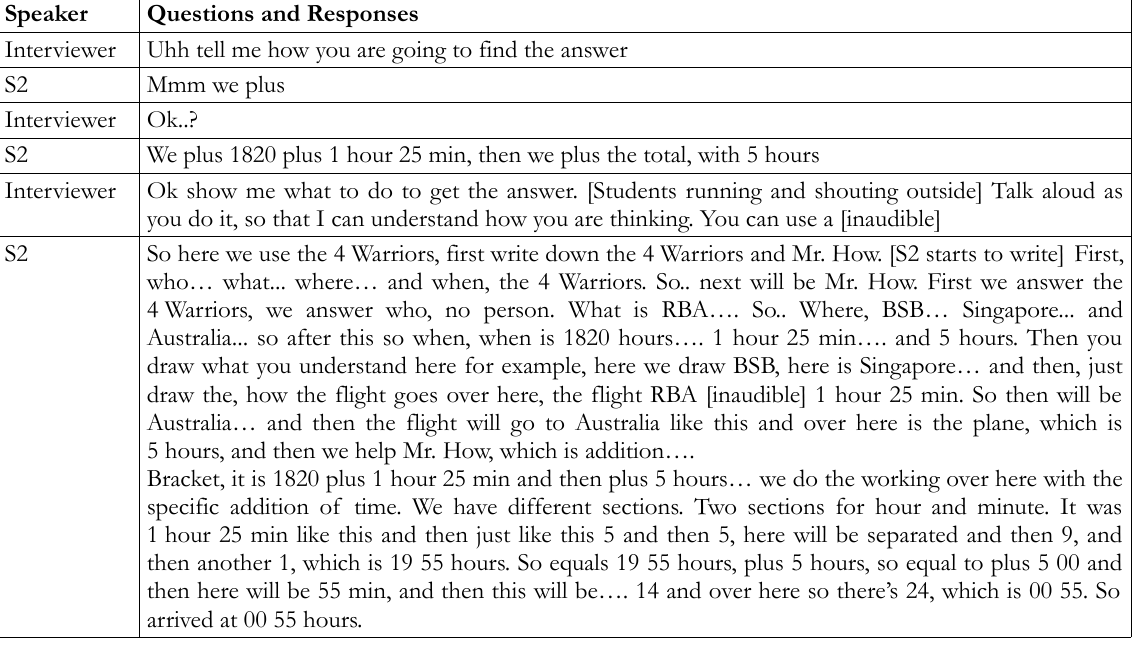
Table 6. Interview excerpts from student S2